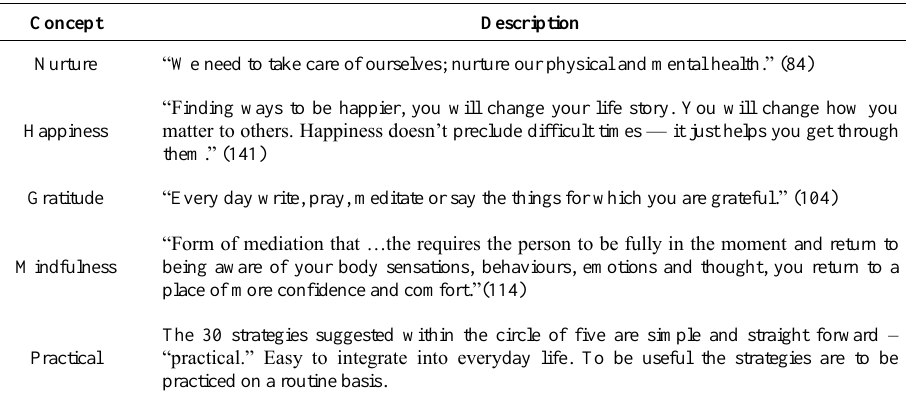
Table 1. Description of the circle of five